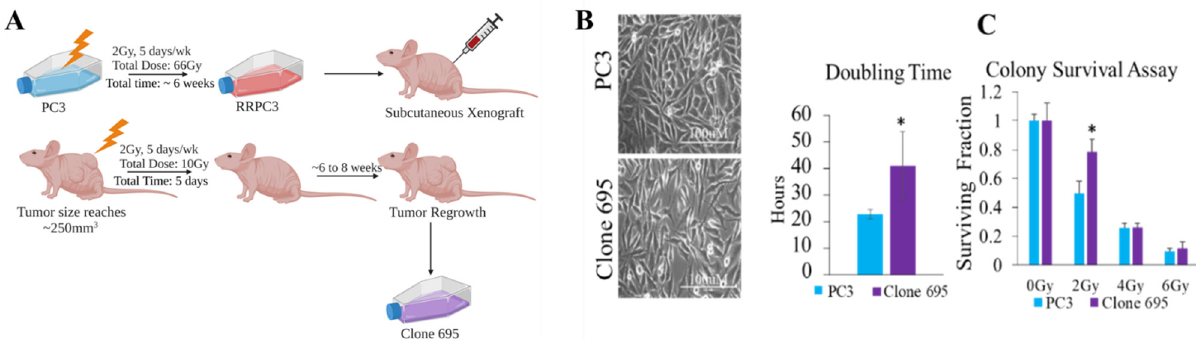
Figure 1. Distinct morphology and survival of Clone 695 cells compared to PC3 cells. ( A ) The process of clone 695 development. ( B ) Cell morphology and cell doubling times of PC3 and Clone 695 cell lines calculated from cell growth curve. ( C ) Colony survival assay of PC3 and Clone 695 cell lines after cells were irradiated at 0 Gy, 2 Gy, 4 Gy, or 6 Gy. * p -value < 0.05.